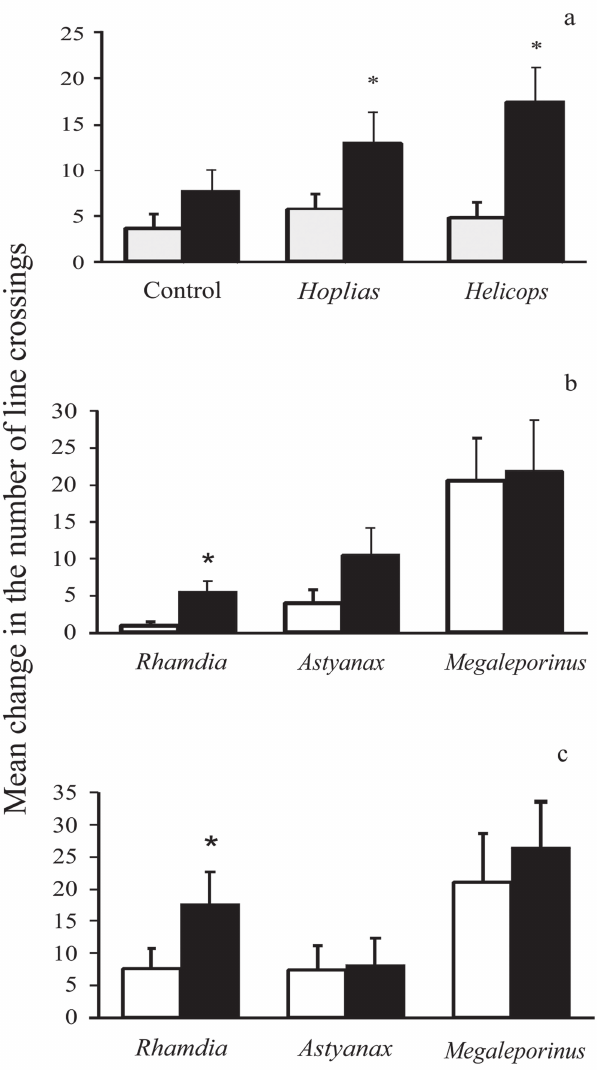
Fig. 2. Mean (± SE) change in the number on line crossings of juvenile catfish after exposure to a. odor of predators Hoplias malabaricus and Helicops infrataeniatus ; b. odor and c. skin extract of conspecifics and non-predators Astyanax lacustris and Megaleporinus obtusidens . Open bars = pre stimulus; solid bars = post-stimulus; *indicates a significant difference (p <